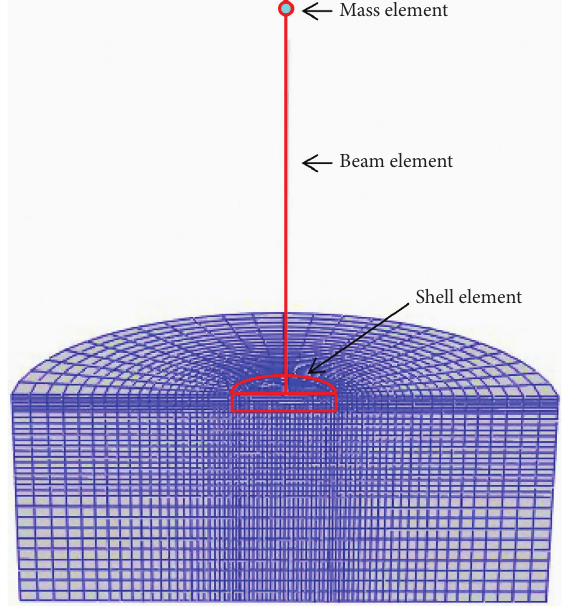
Figure 2: Finite element